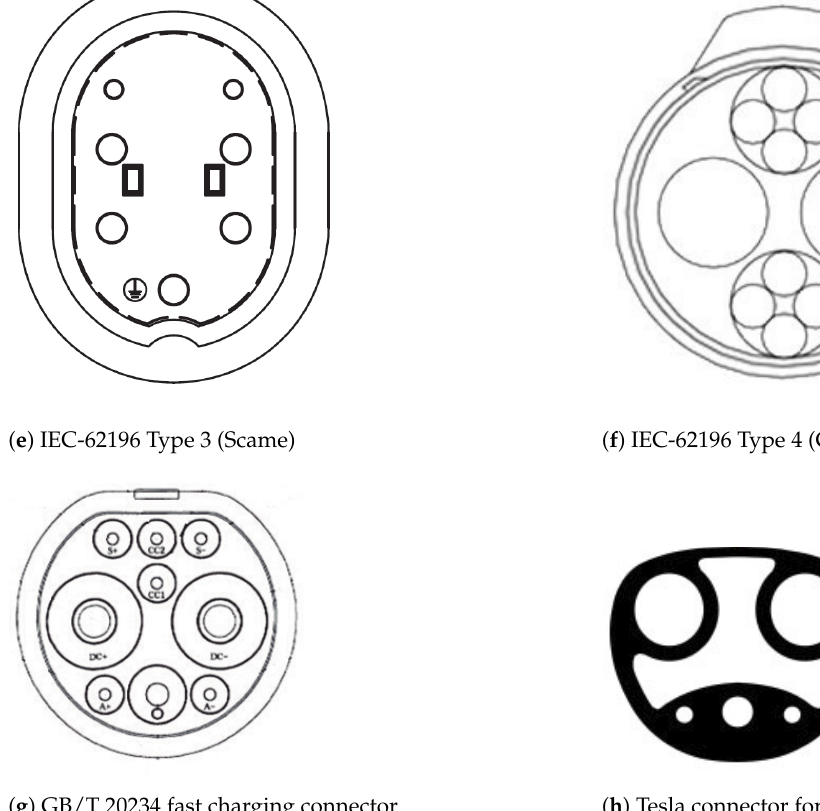
Figure 7. EV Connectors considered by the different standards